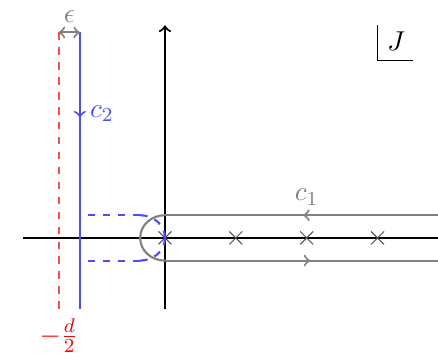
Figure 2 . Illustration of contour integrals of Watson-Sommerfeld transformation. Left: sum over non-negative integers as a set of contour integrals around the integers (3.46). Right: deforming the contour to a line integral with constant real